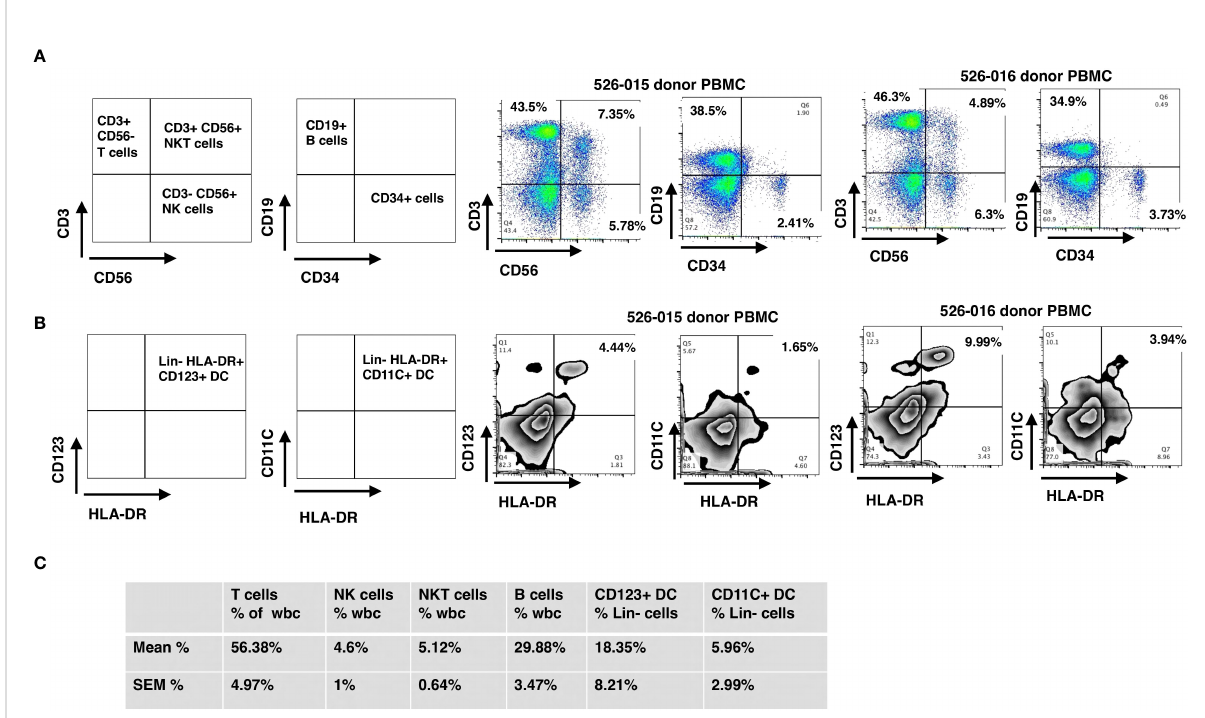
FIGURE 1 Immunophenotyping of mononuclear cells added back using fl ow cytometry. The fi nal products for HSC grafts were characterized by staining with antibodies against: CD3, CD56, CD19, lineage markers (CD3, CD14, CD16, CD19, CD20 and CD56), HLA-DR, CD123, and CD11c. (A) Representative fl ow cytometry dot plots of T, NK, NKT and B cells (donor 526-015) of WBC. (B) Representative fl ow cytometry dot plots of CD123 + DC and CD11c + DC (donor 526-015) of Lin- (lineage negative) cells. (C) Mean and SEM for the cell subsets of all donors. SEM, standard error of the